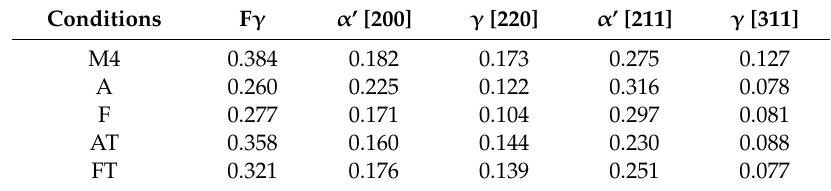
Table 4. Initial volume fraction of the retained austenite (integrated XRD peak